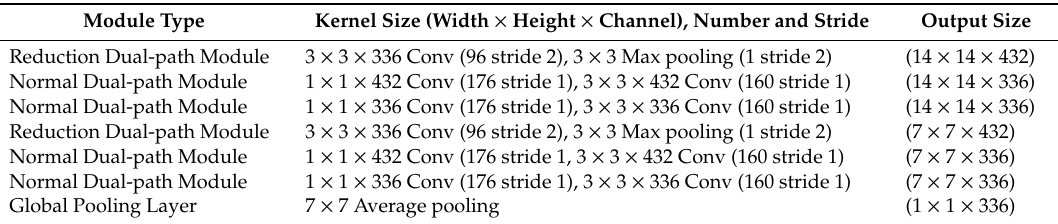
Table 5. New version of six inserted dual modules following the last normal dual module of the original CNN